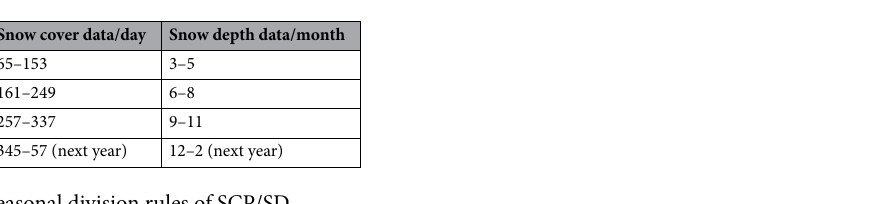
Table 4. Seasonal division rules of